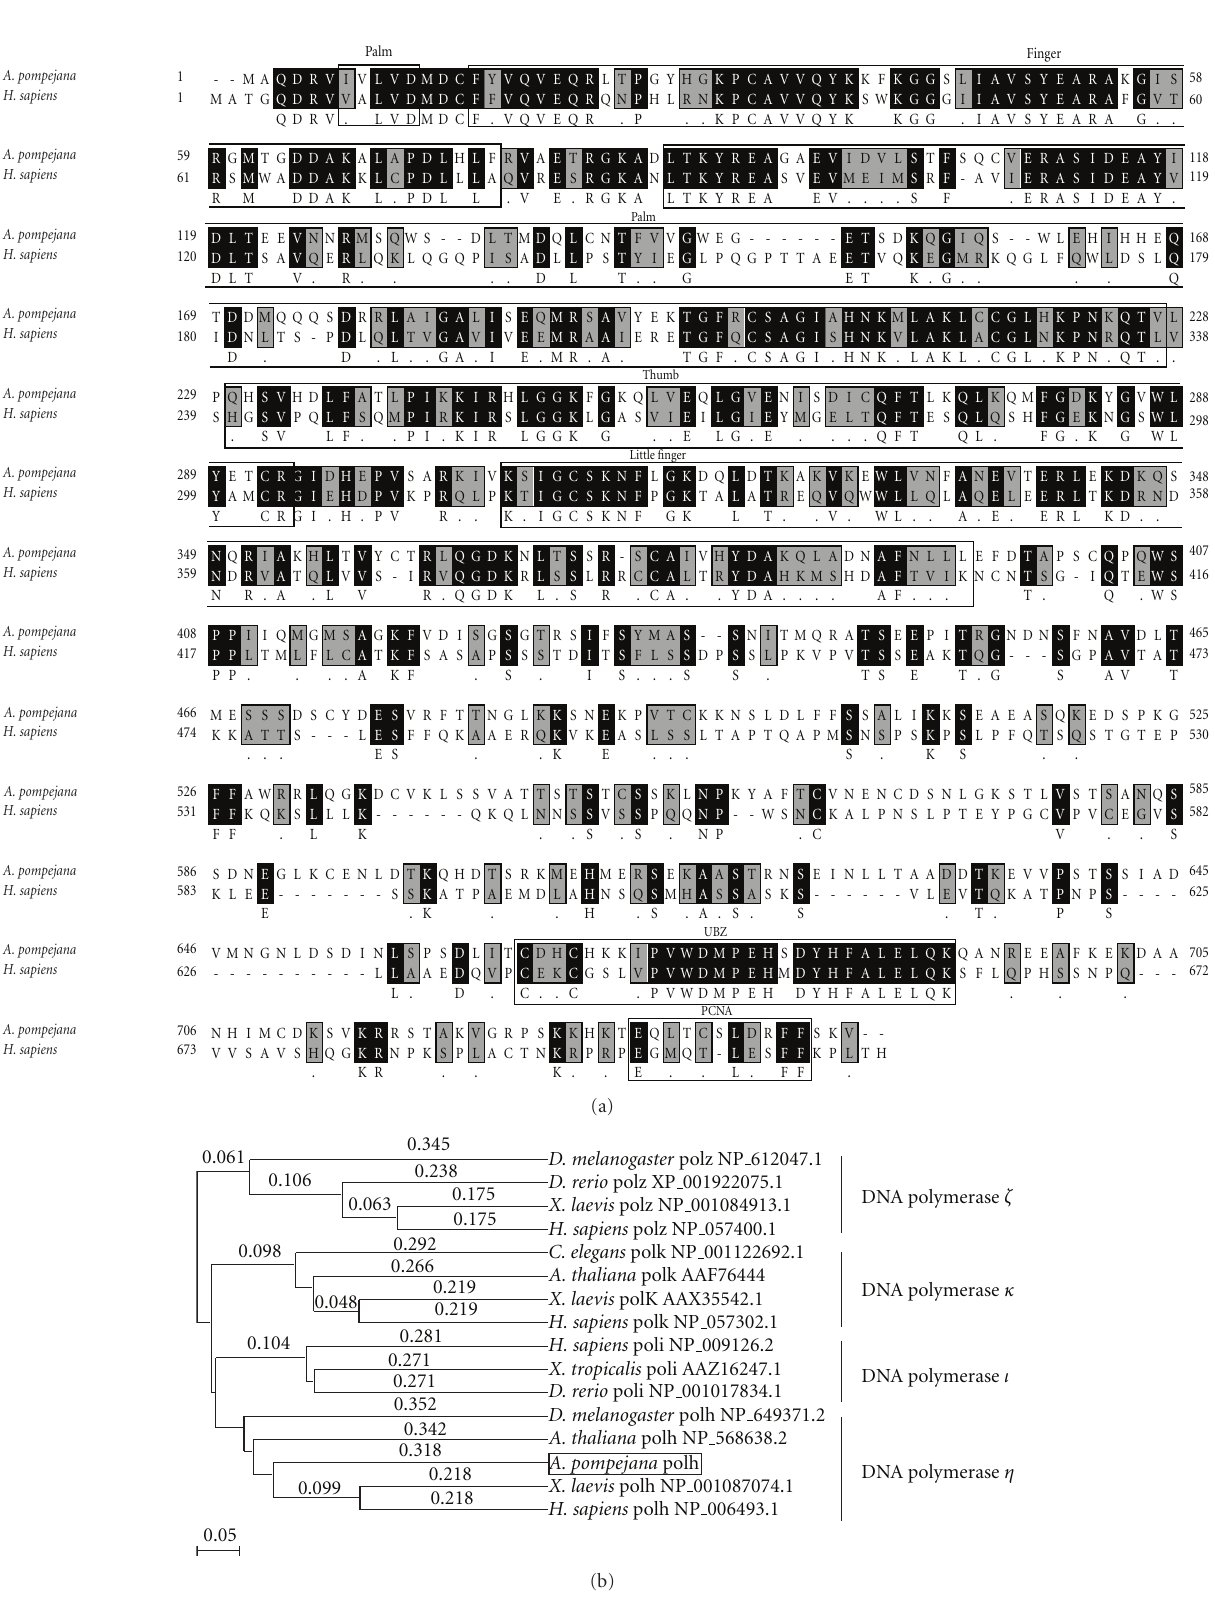
Figure 1: (a) Alignment of the amino acid sequences of ApPol η and HsPol η (NP 006493.1). Identical and similar residues between the two enzymes are indicated in black and grey, respectively. (b) Phylogenetic analysis of TLS polymerases. A phylogenetic tree was constructed by the UPGMA method, based on the amino acid sequences of the ApPol η and other Y- and B-family DNA